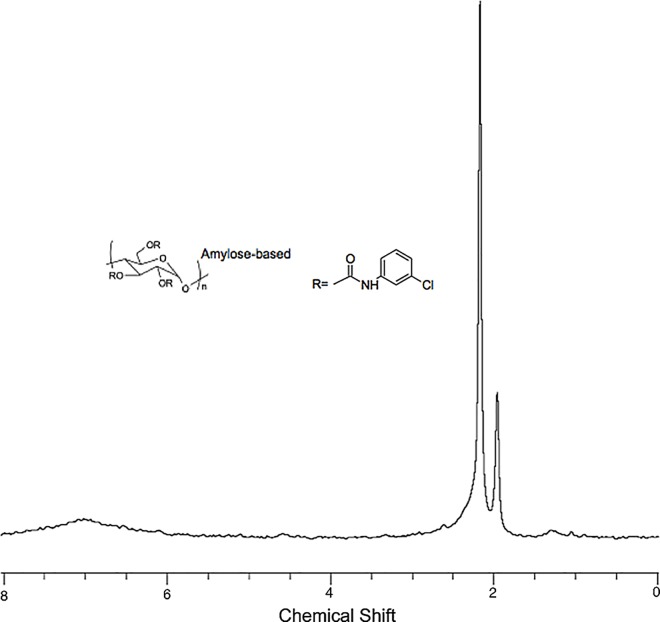
1H HR-MAS NMR spectrum of CHIRALPAK ID (Amylose 3-chlorophenylcarbamate-selector).1 mg suspended in 12 μL of ACNd3/DEA (100:0.1, v/v).